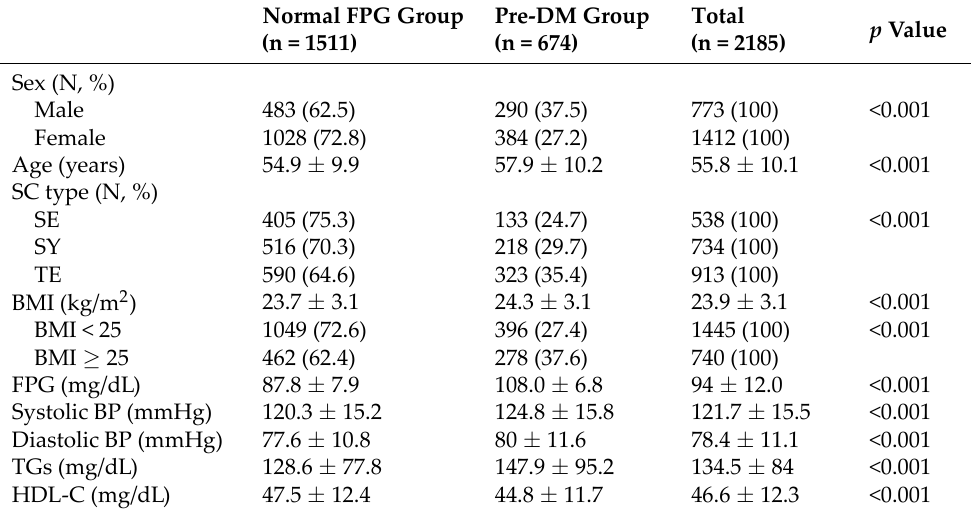
Table 1. General